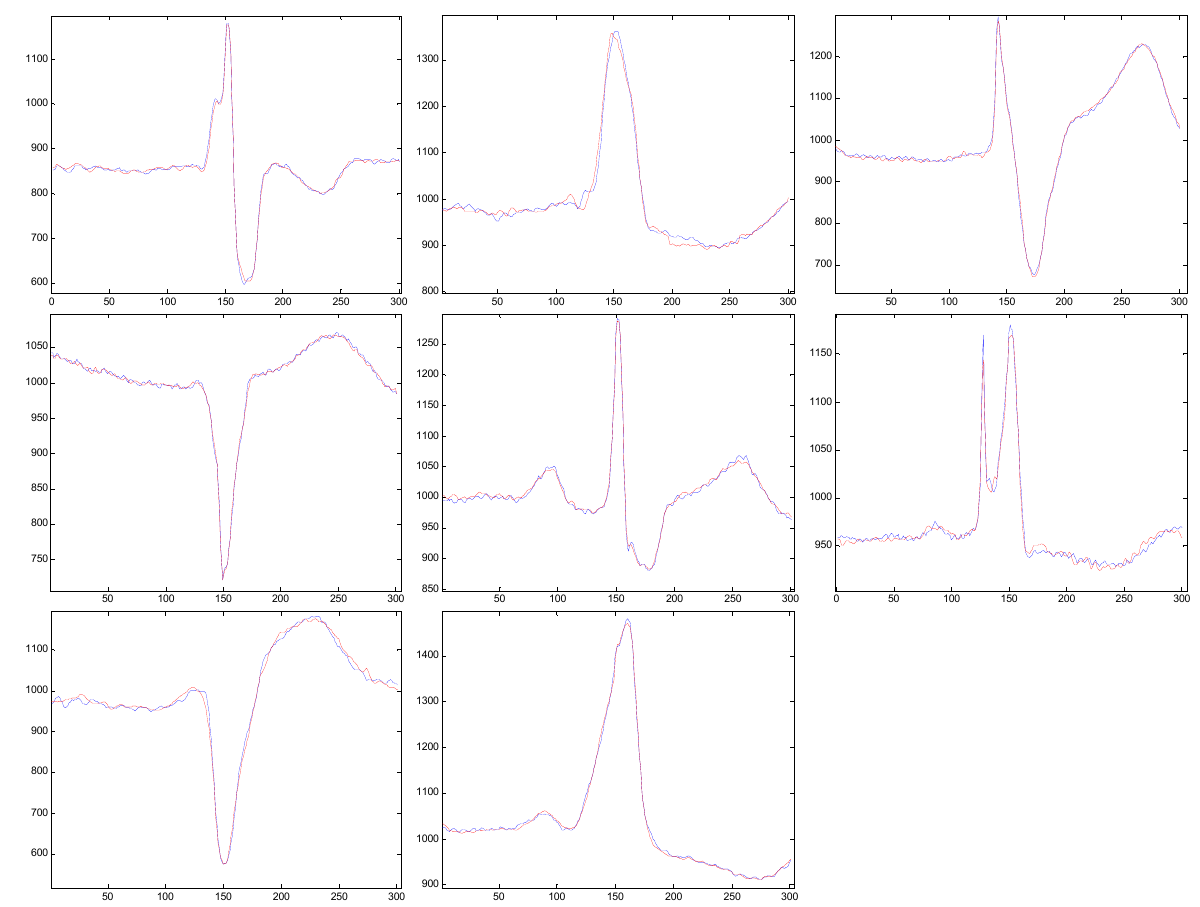
Figure 5. Original and reconstructed signals with pathology-specific dictionaries. Table 6. Results summary for dictionaries with a centered